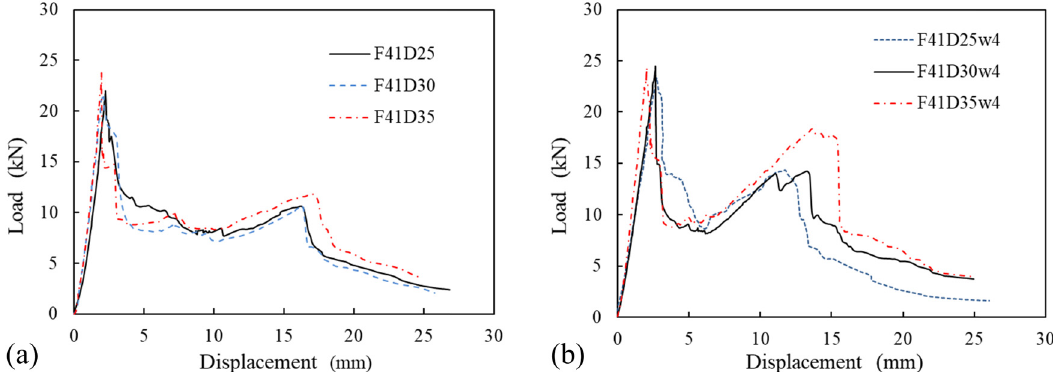
Figure 8: Effect of the thickness of the foam core. ( a ) Sandwich specimens without lattice webs. ( b ) Sandwich specimens with lattice webs.